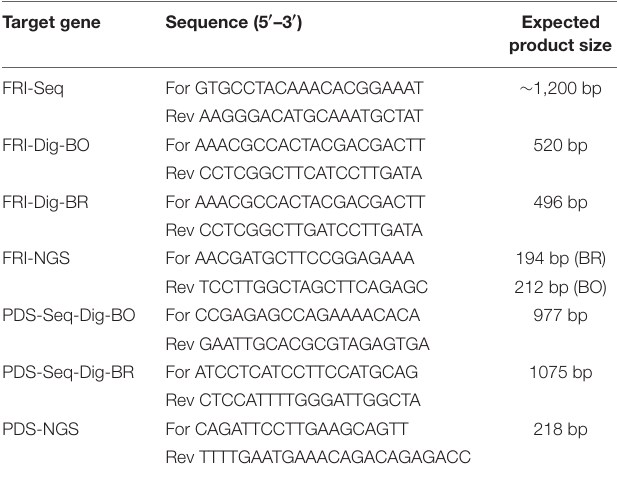
TABLE 1 | Sequences of primers used for amplification of CRISPR target loci of FRI and PDS genes of B. oleracea , B. napus, and B. rapa . Target